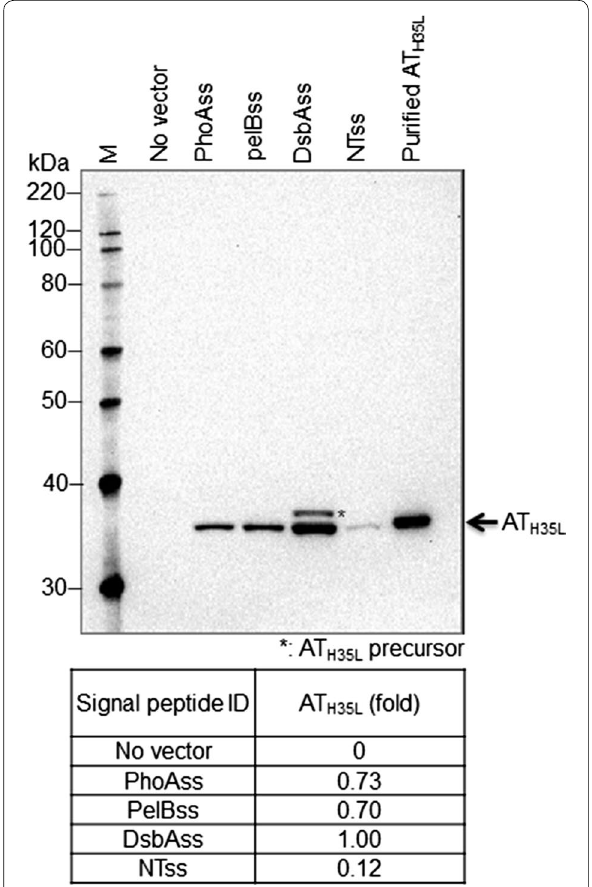
Fig. 1 Western blot analysis of cell culture medium from AT H35L signal sequence variants in a Micro24 fed-batch process. Arrow indicates released mature AT H35L protein from live cells and asterisk indicates leaked AT H35L precursor from dead cells. Purified AT H35L protein was used as a reference. In the table, the levels of secreted AT H35L protein in culture medium were quantified by the band intensity of AT H35L from SDS-PAGE gel using the Image J 1.50i (Schneider et al.